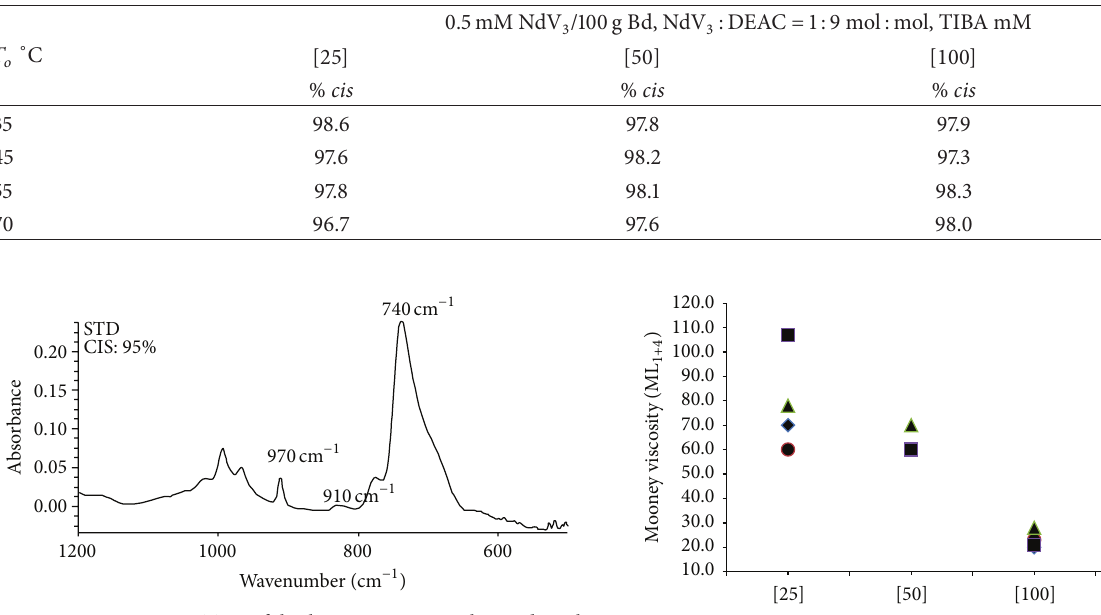
Figure 4: Spectrum FTIR of high cis -1,4-BR synthesized with 0.5 mM NdV 3 /100g Bd, NdV 3 : DEAC = 1: 9 mol :mol, and TIBA = 200 mM.